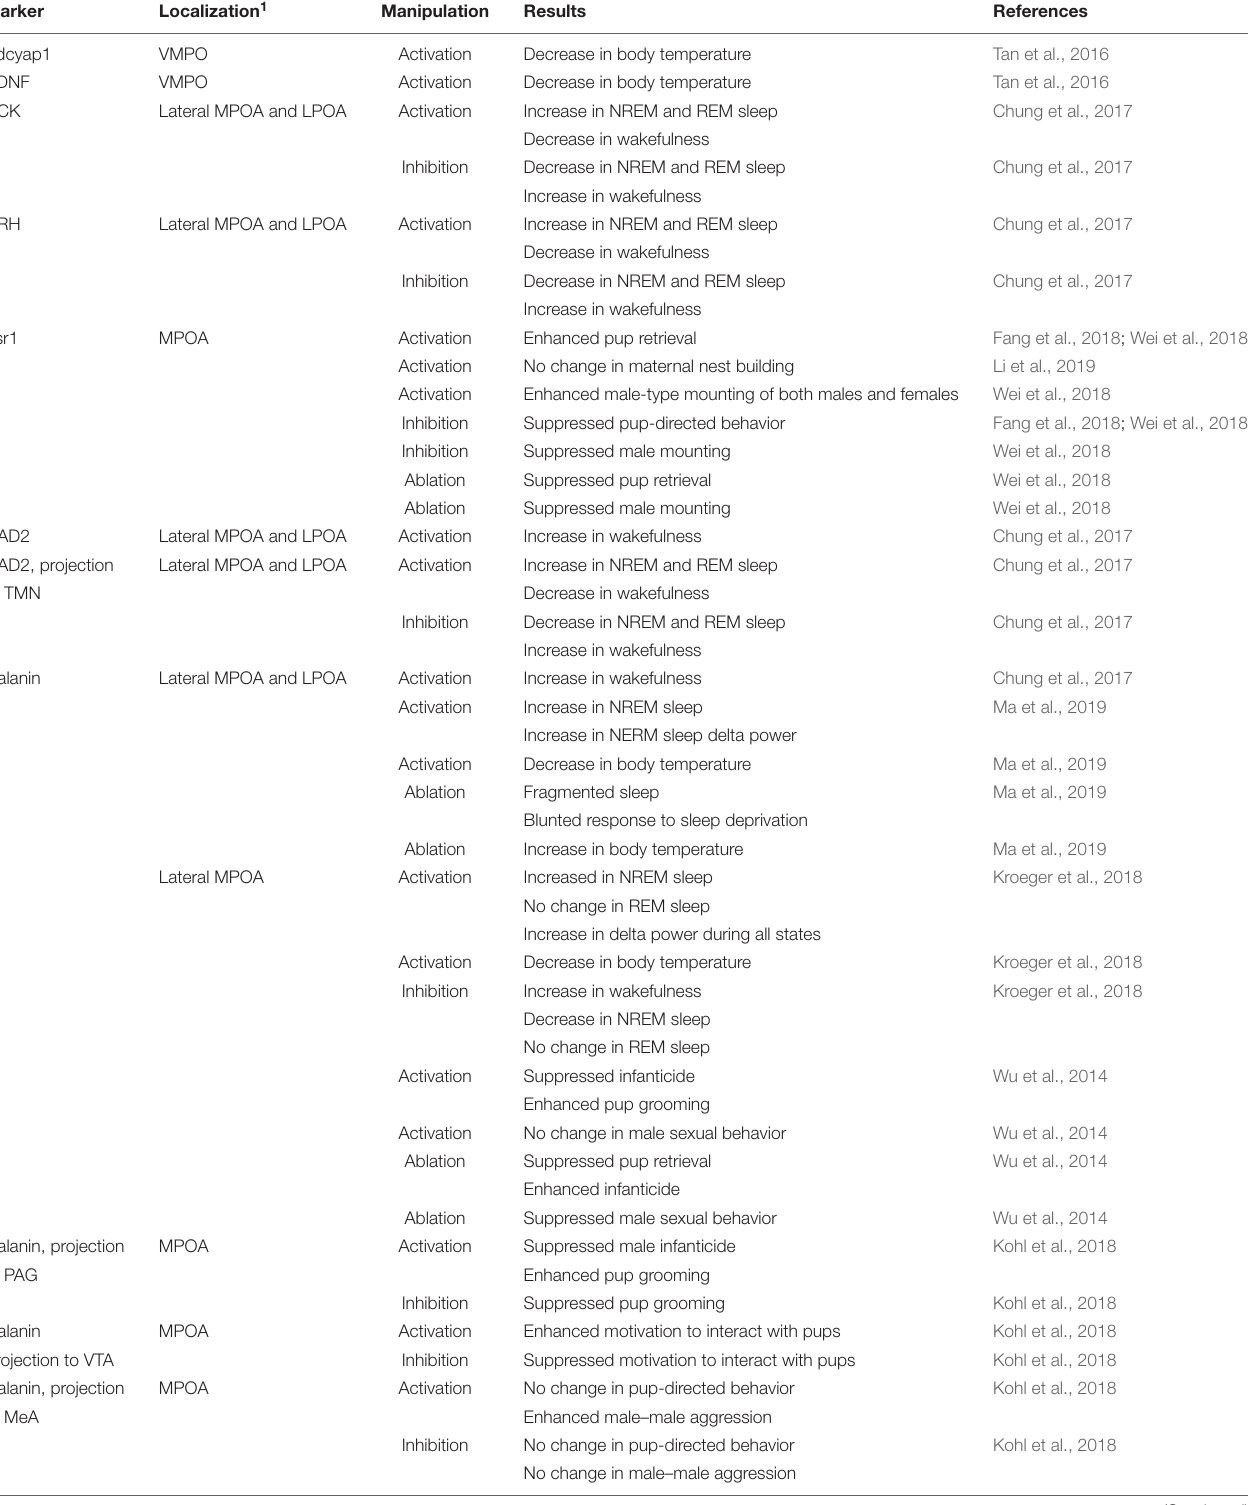
TABLE 1 | Preoptic area neuron subtypes that regulate physiology and